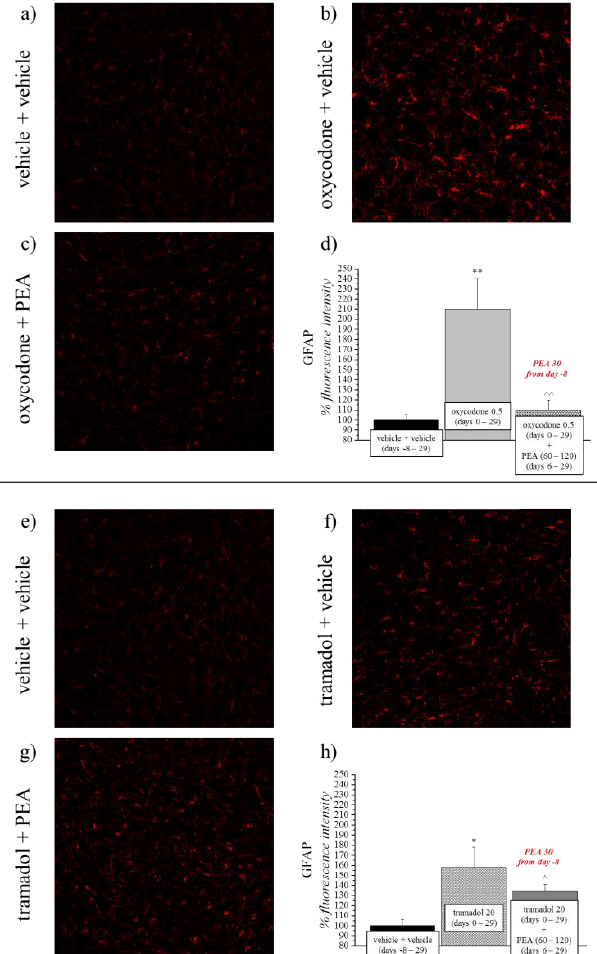
Figure 4. Effect of repeated administrations of PEA on the astrocytic profile in the lumbar spinal cord. Rats were treated with the vehicle or pre-emptive PEA (30 mg kg − 1 ) p.o. daily (in the evening) for the duration of the experiment, starting on Day − 8. ( a – d ) Oxycodone (0.5 mg kg − 1 s.c.) was administered from Day 1 until the complete loss of the antinociceptive response was achieved (Day 29). From Day 6, animals treated with oxycodone + pre-emptive PEA received an additional acute daily PEA treatment (60–120 mg kg − 1 ) in co-administration with the opioid until Day 29. ( e – h ) Tramadol (20 mg kg − 1 s.c.; Group g) was injected from Day 1 until the complete loss of the antinociceptive response was achieved (Day 29). From Day 6, animals treated with tramadol + pre-emptive PEA received an additional acute daily PEA treatment (60–120 mg kg − 1 ) in co-administration with the opioid until Day 29. The number of GFAP-positive cells was counted in the dorsal horn of the L4–L5 spinal cord. Transverse sections of spinal cord were imaged at × 20 objective (scale bar = 50 µ m). Histograms show a quantitative analysis of the GFAP fluorescence intensity. Each value represents the mean ± S.E.M. of six rats, obtained by analysing four independent fields for both sides of the dorsal horn of the lumbar spinal cord. Statistical analysis was one-way ANOVA followed by Bonferroni’s post hoc comparison. * p < 0.05 and ** p < 0.01 vs. vehicle + vehicle group; ^ p < 0.05 and ^^ p < 0.01 vs. oxycodone or tramadol + vehicle treated animals.